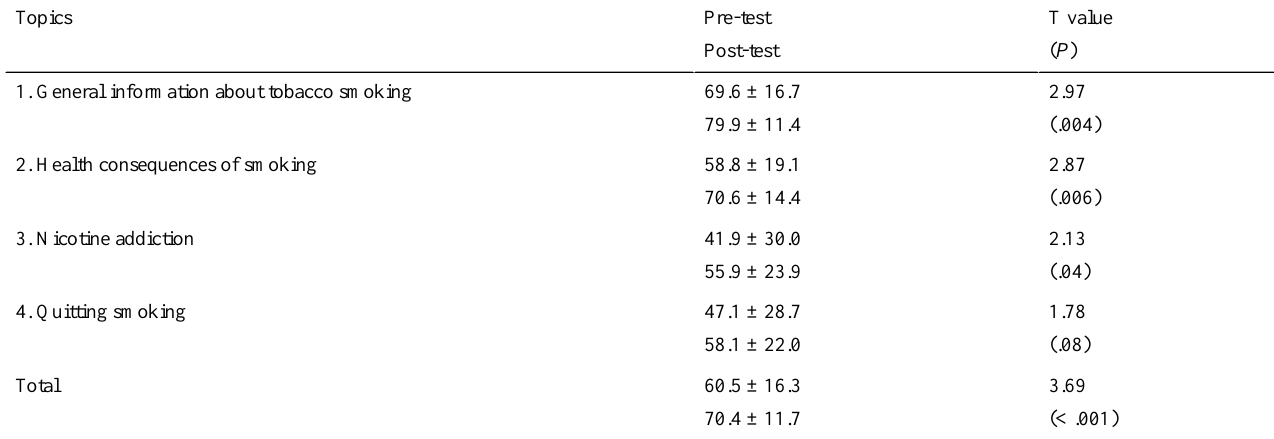
Table 4. Hazards of smoking knowledge scores before and after the intervention (N =